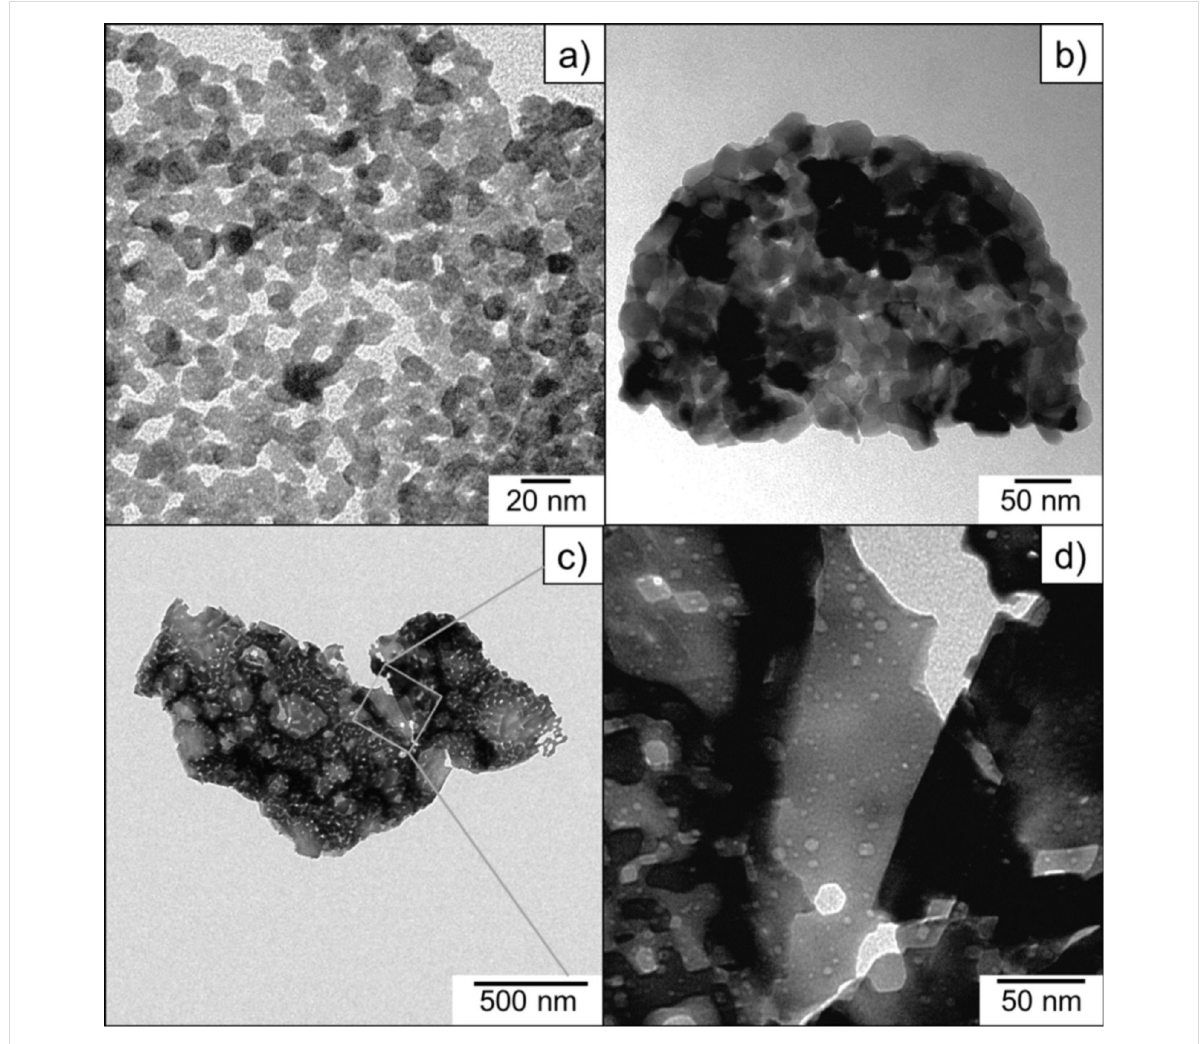
Figure 7: TEM images of the a) Mn 3 O 4 , b) Mn 5 O 8 , and c) and d) α -Mn 2 O 3